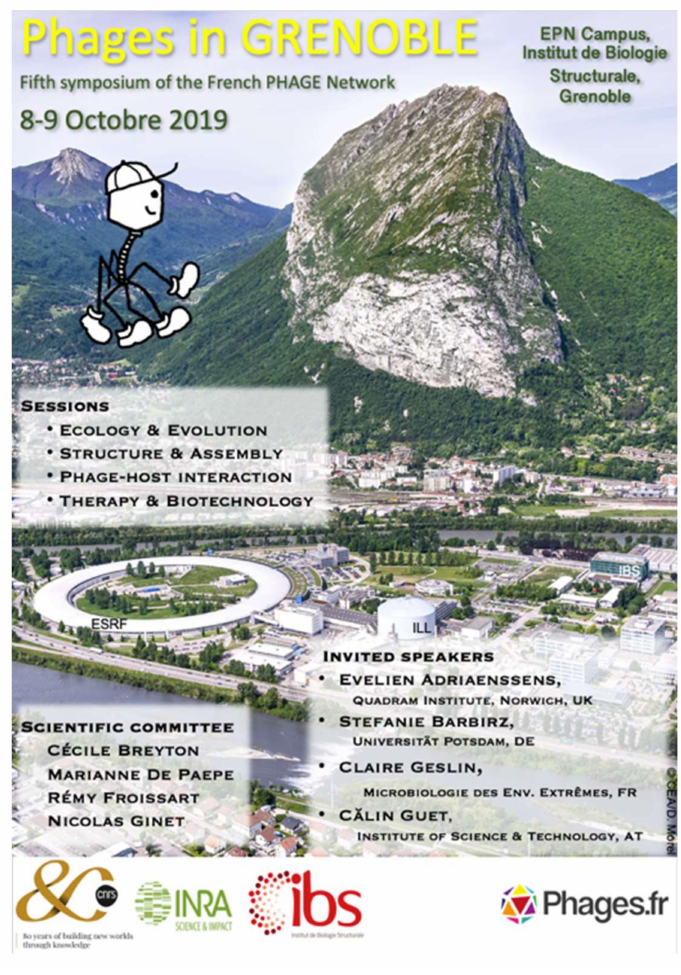
Figure 1. Poster of the Phage in Grenoble